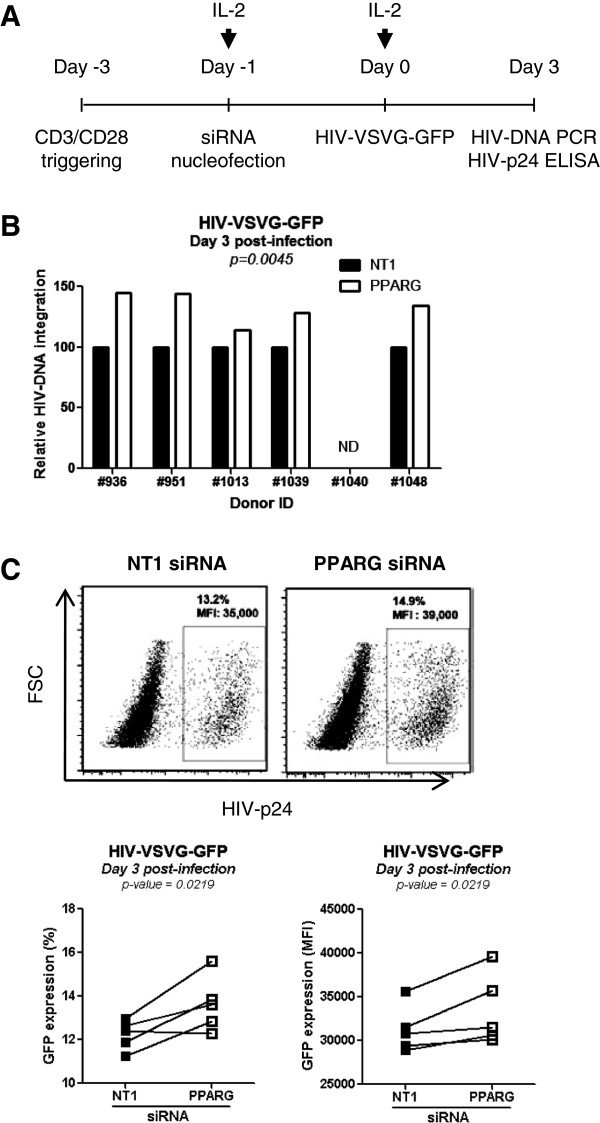
PPARγ pathway negatively regulates HIV replication in T-cells at levels post-entry and prior integration. (A) CD4+ T-cells were isolated, activated via TCR and nucleofected with PPARγ vs. NT1 siRNA as described in Figure 6. Cells were exposed to single round HIV-VSVG-GFP at 24 h post-nucleofection and cultured for three days in the presence of IL-2. (B) Shown are levels of integrated HIV-DNA (n = 5). (C) Shown is the frequency and MFI of GFP-expressing cells in one representative subject (upper panels) and statistical analysis in n = 5 different subjects (lower panels). Paired t-Test values are indicated on the graphs.